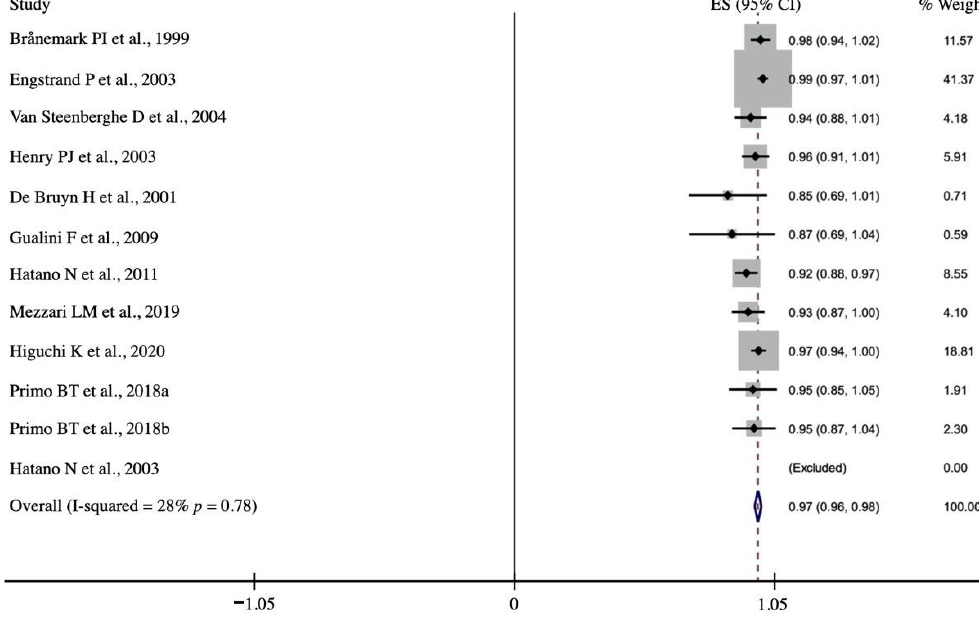
Figure 3. Forest plot. Prosthetic survival rate after 1–6-year follow-up.